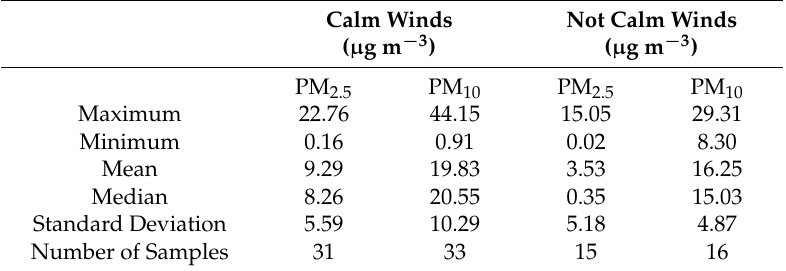
Table 1. Comparison of concentrations of PM 2.5 and PM 10 ( µ g m − 3 ) during both calm and not calm wind conditions. Calm wind conditions are considered to be conditions where the median wind speed is less than 1